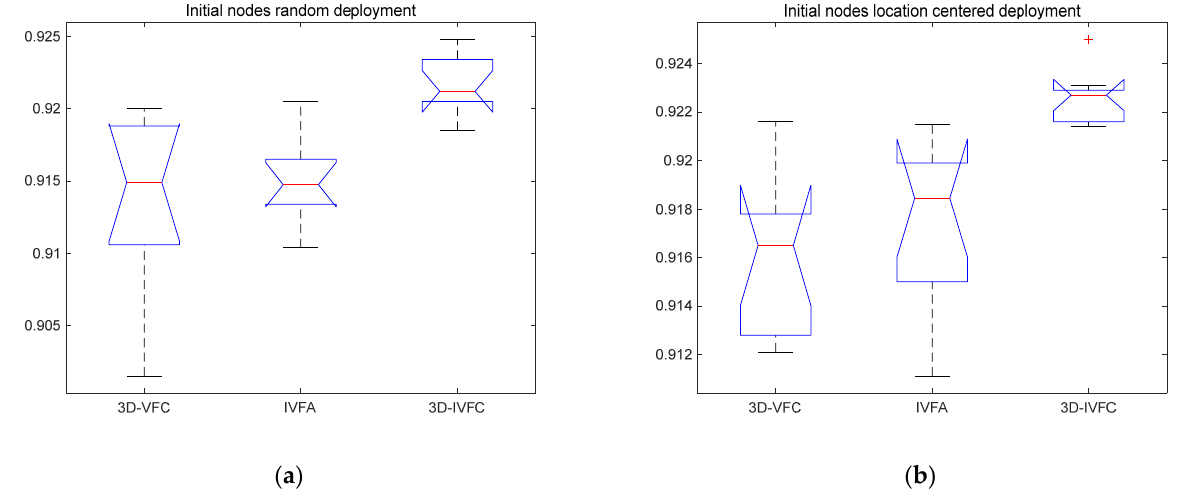
Figure 9. The boxplot results of the proposed algorithm in both cases. ( a ) Comparison boxplot results of case 1. ( b ) Comparison boxplot results of case 2.